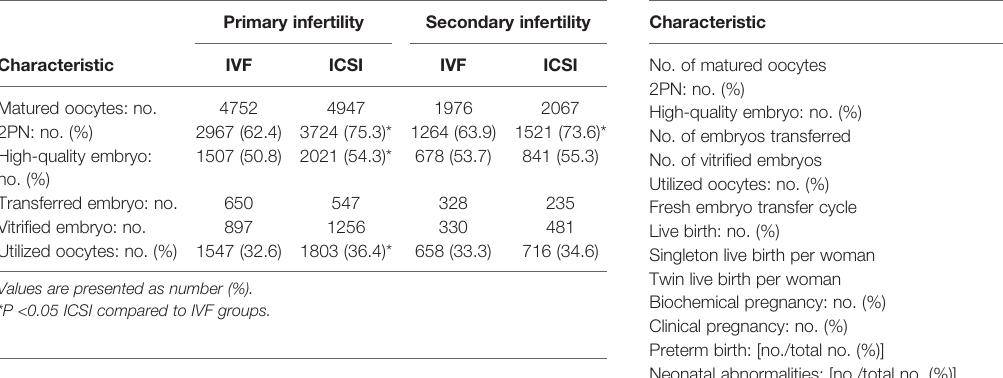
TABLE 4 | Clinical outcome of half-ICSI patients with fresh embryo-transfer cycles. Characteristic